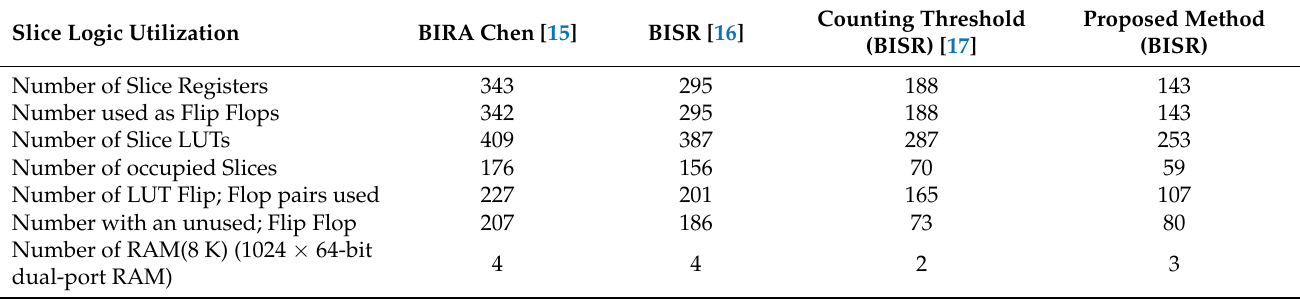
Table 6. Comparison of the area with the existing methods and proposed BISR approach.